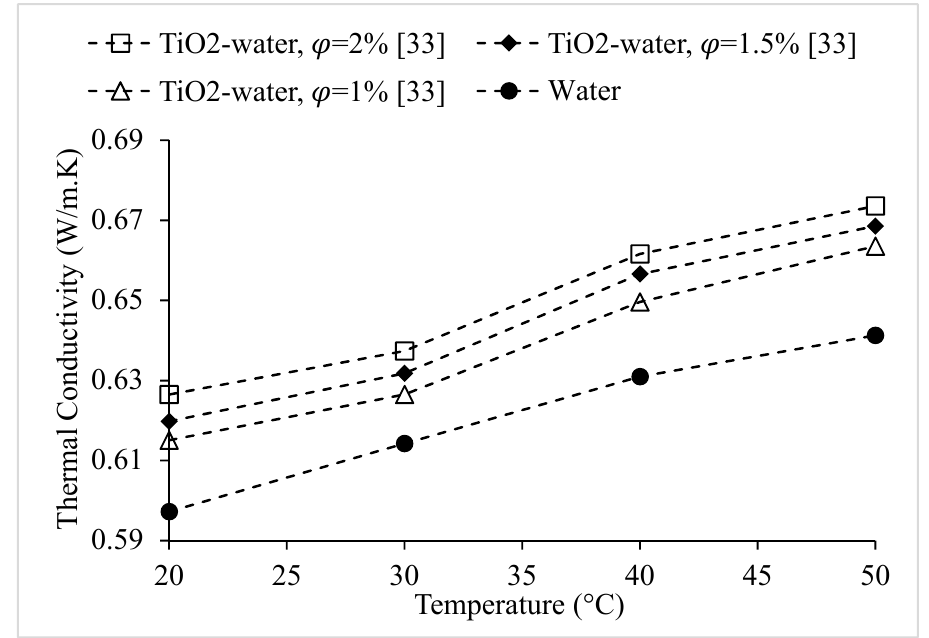
Figure 18. Variation of thermal conductivity of TiO 2 –water nanofluid at nanoparticle volume concentrations of 𝜑 = 1%, 1.5%, and 2% , as a function of temperature, °C.